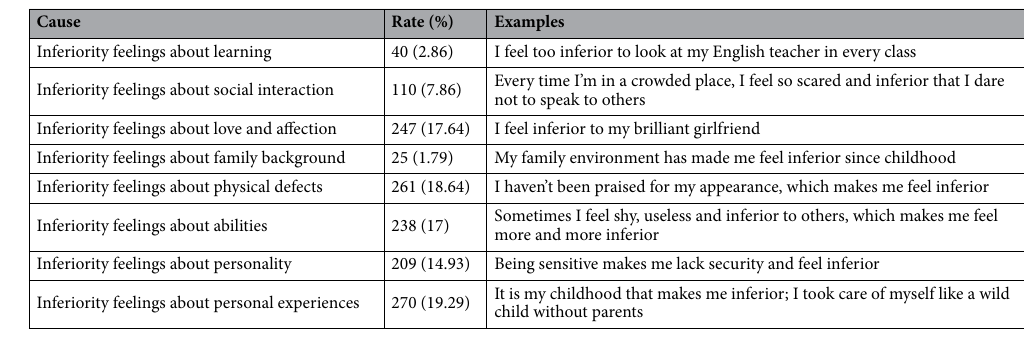
Table 2. Causes of inferiority